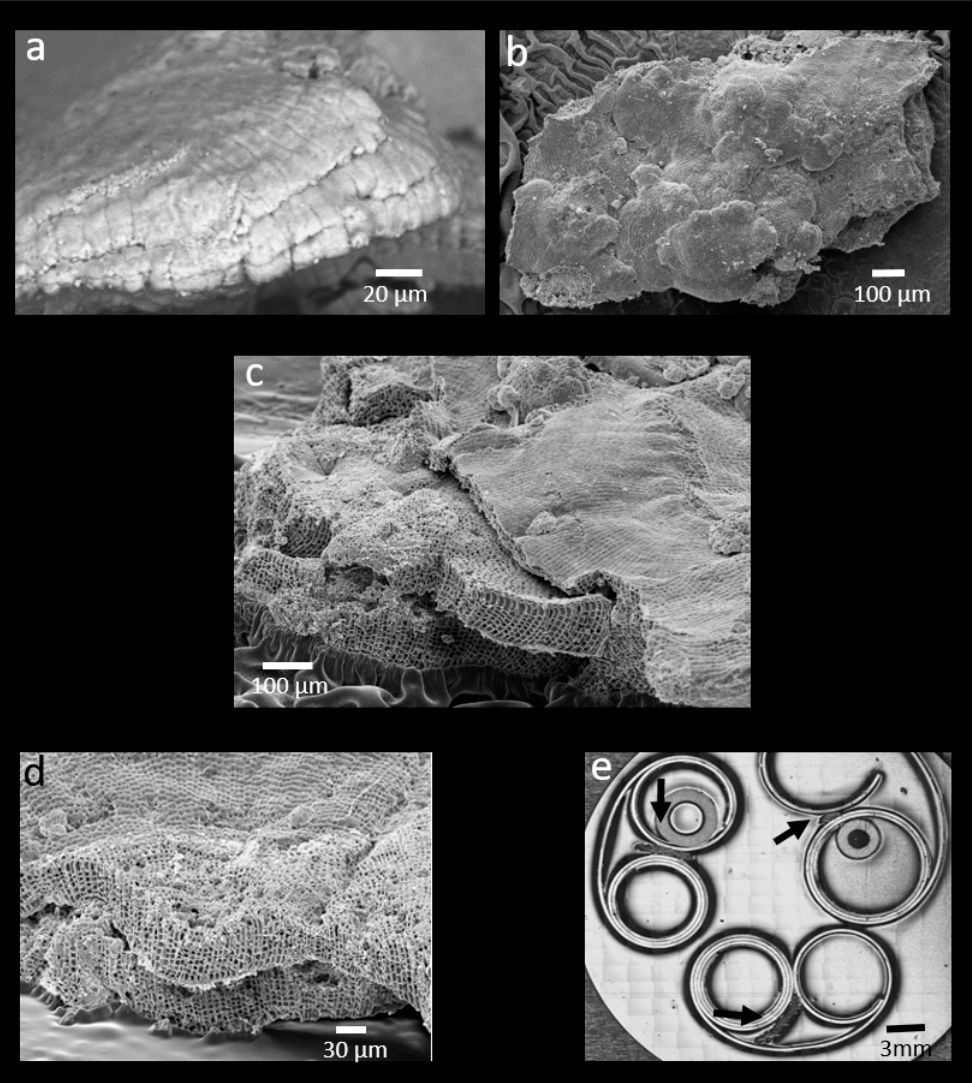
Figure 5. Structure and sample preparation of Pneophyllum cetinaensis ( a – c ). Pneophyllum cetinaensis layered thallus, arranged in superimposed flattened or curved fragile branches. ( d ) Example of thallus layer used for the analysis. ( e ) Stub with polished Pneophyllum cetinaensis thalli (black arrows), ready to be measured.